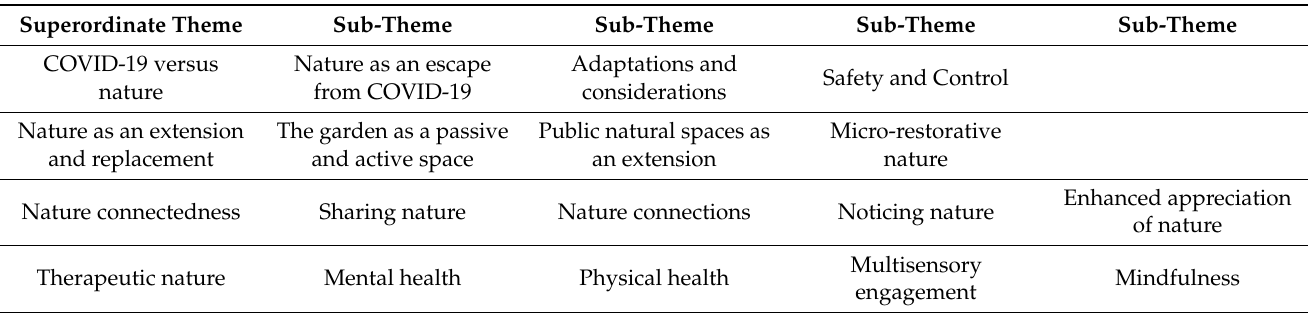
Table 2. Superordinate themes and